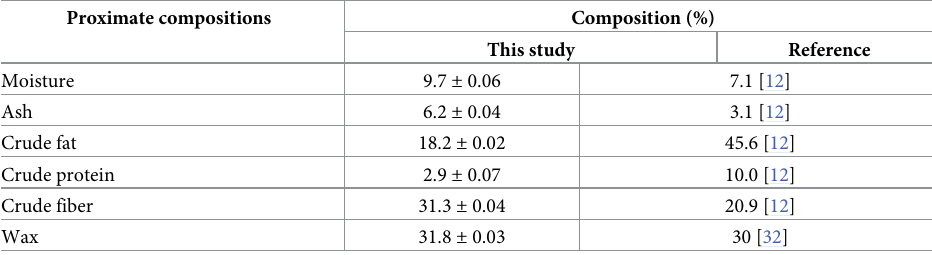
Table 1. Composition of propolis used in this